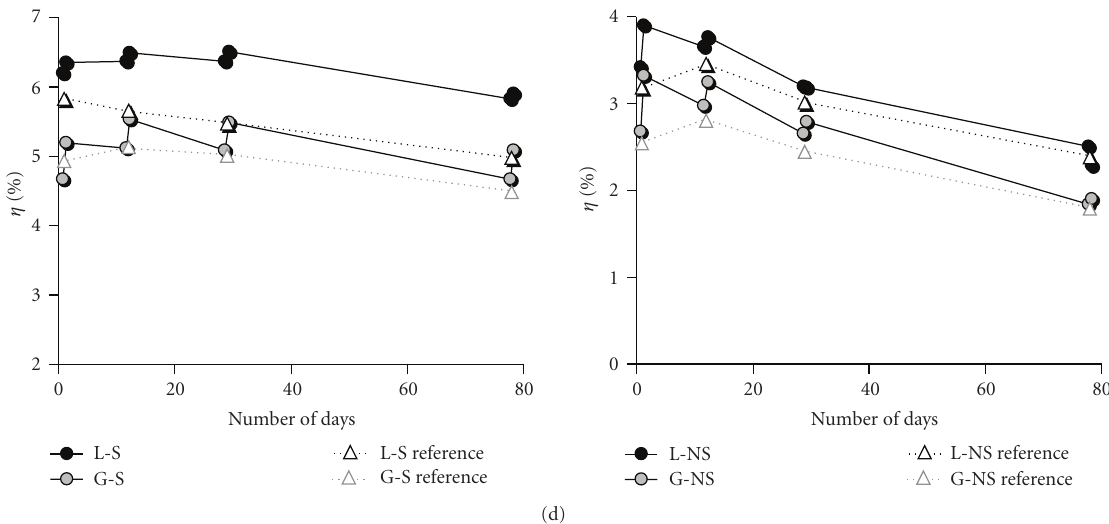
Figure 2: The average IV-parameters as a function of time, before and after every temperature treatment (pairs of two consecutive markers) versus reference cell values. (a) Open circuit voltage V oc , (b) short circuit current density I sc , (c) fill factor FF, and (d) power conversion e ffi ciency η . Standard deviations are not marked in the figures but their values fell on the range 0–0.01 V for the V oc , 0.4–1 mA/cm 2 for the I sc , 1%–4% for the FF, and 0.1%–0.5% for the η (the largest values typical to the most aged nonsintered cells). Small initial standard deviations indicated even cell quality which is why the final number of temperature-treated cells could be limited to three and that of the reference cells to